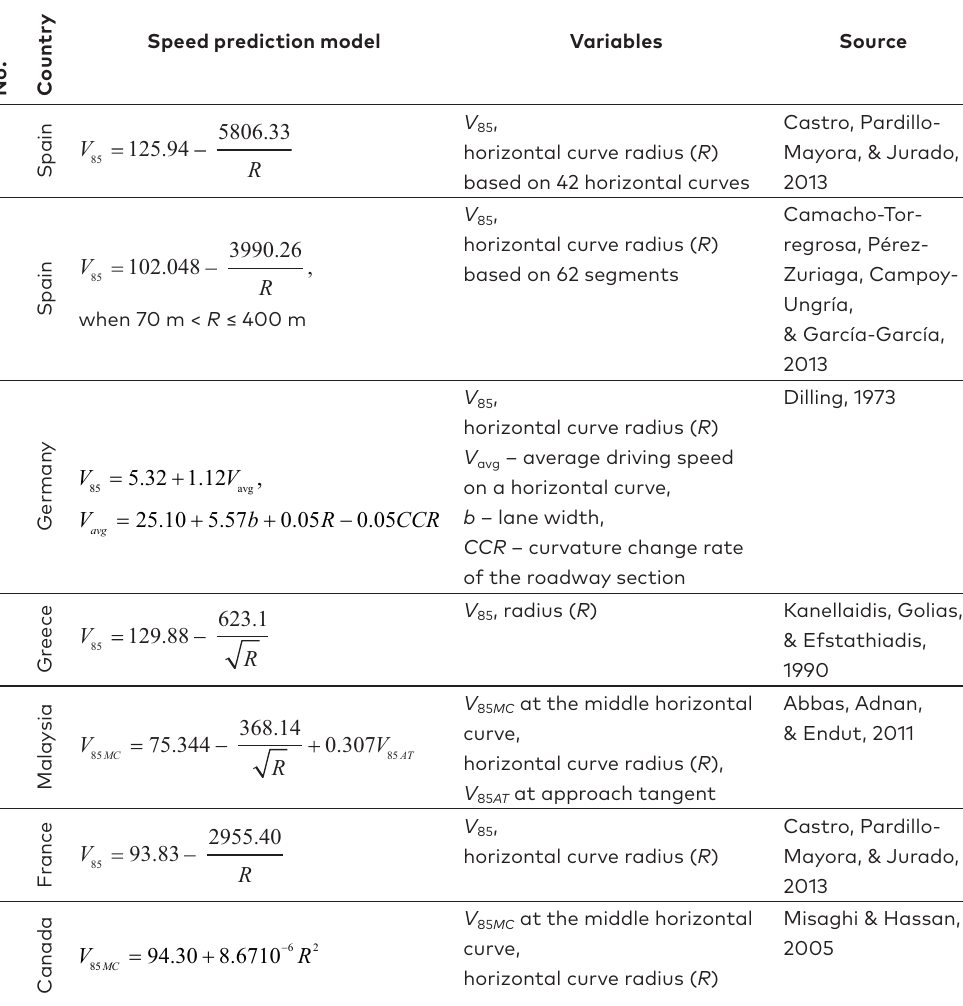
Table 1. Operating Speed Prediction Models developed by various authors